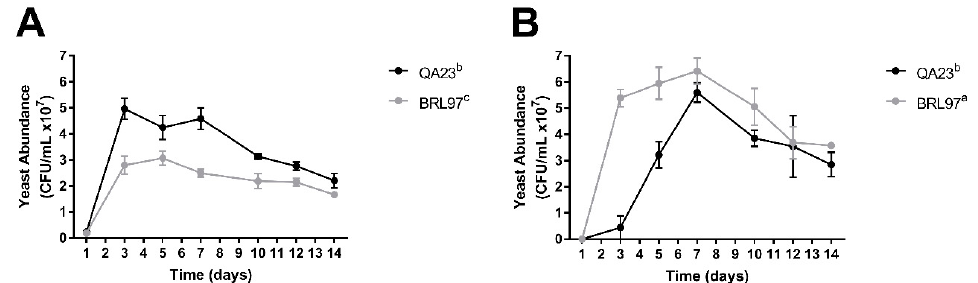
Figure 2. Total yeast abundance (CFU/mL ± SEM) during controlled fermentations conducted by different yeast strains ( n = 4 per treatment). Fermentations were conducted in the presence of either ( A ) 0 mg/L SO 2 or ( B ) 50 mg/L SO 2 . Treatments with different superscript letters indicate significantly different yeast abundance dynamics throughout fermentation (2-factor repeated measures ANOVA, α = 0.05).